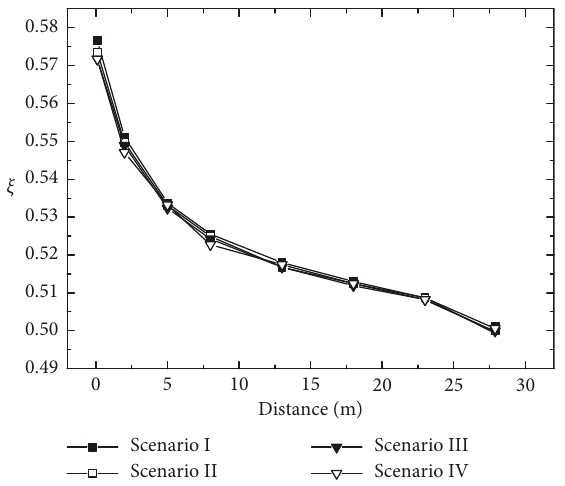
Figure 21: Trend of the maximum values of ξ